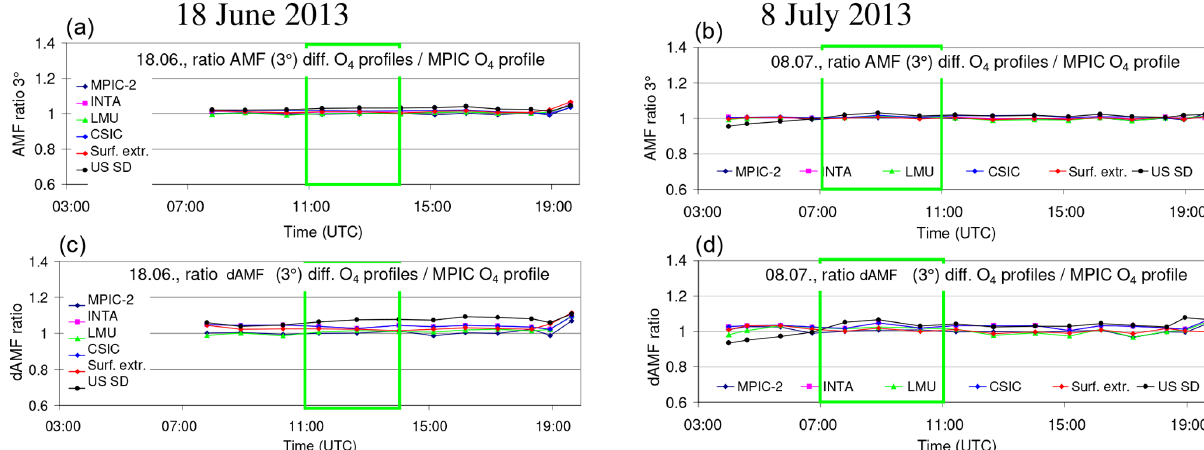
Figure A6. Ratios of the O 4 AMFs (a, b) and O 4 dAMFs (c, d) derived for different O 4 profiles vs. the standard O 4 profile (MPIC) for both selected days. Besides the results for O 4 profiles extracted by the different groups, the results for O 4 profiles derived from the US standard atmosphere and for the extrapolation of the surface values are included.